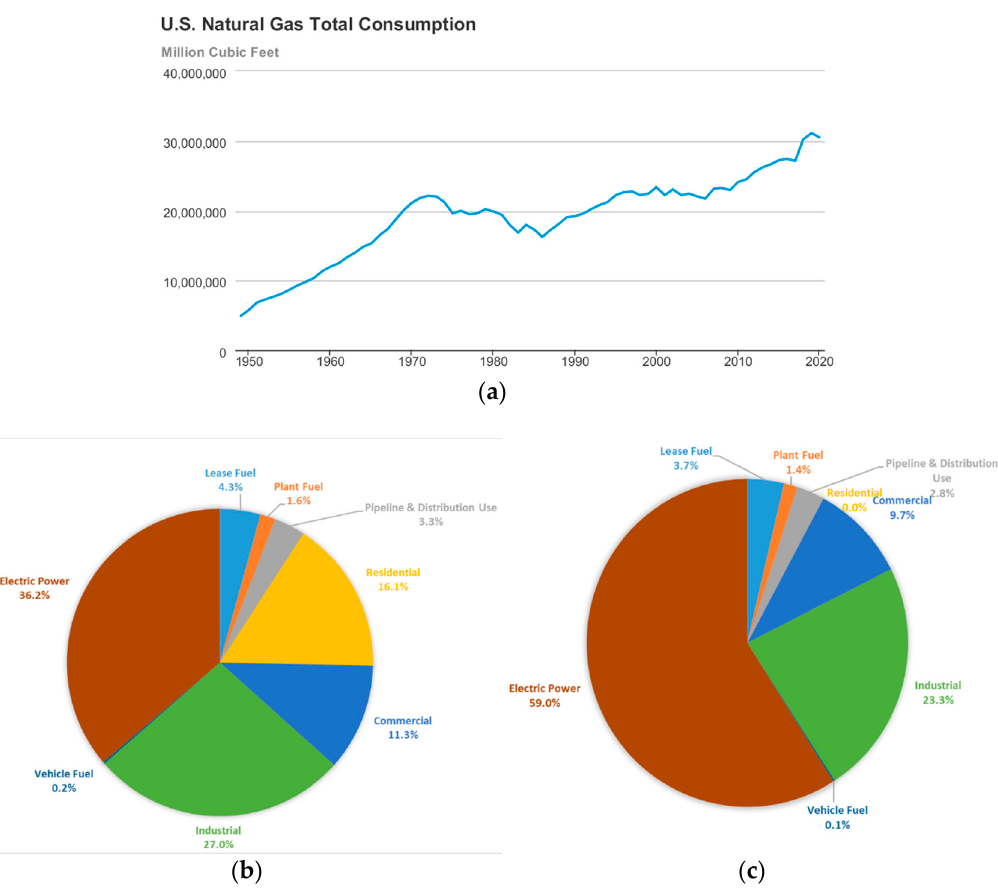
Figure 11. Natural gas consumption situation in the United States and future prediction: ( a ) U.S. natural gas residential consumption from 1949 to 2020 [145]. ( b ) U.S. NG consumption in 2019 (before pandemic) [145]. ( c ) U.S. NG consumption prediction.